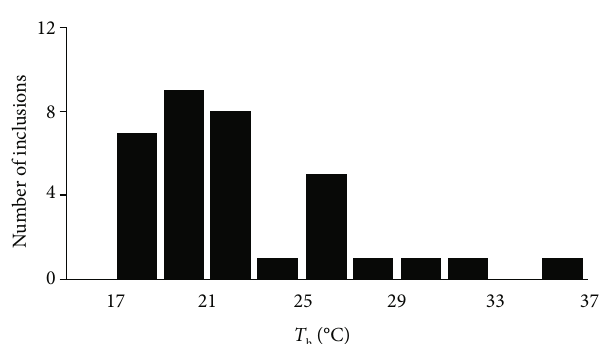
Figure 5: The T distribution in the Kunteyi halite of borehole hMAX ZK3608.